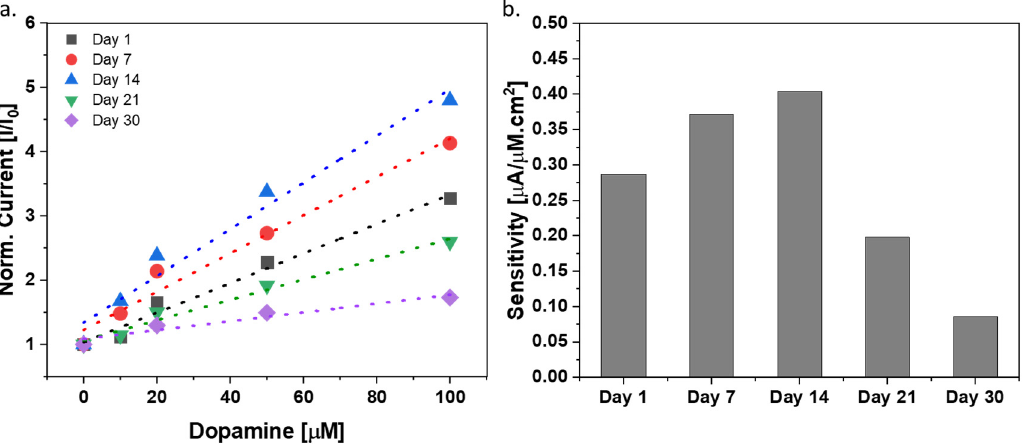
Figure 7. Electrochemical performance of the biosensor during degradation. ( a ) Electrochemical response of the O3ES towards DA over a period of 1 month in the presence of protease enzyme in PBS; and ( b ) sensitivity of the O3ES towards dopamine under ~1 month of degradation.